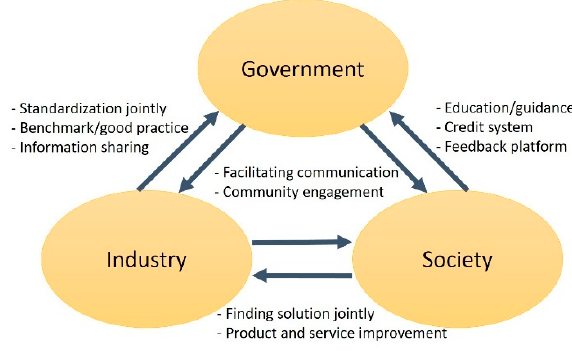
Figure 1. Traditional government roles: ( a ) Government as hard-law regulator; ( b ) Limited government control.